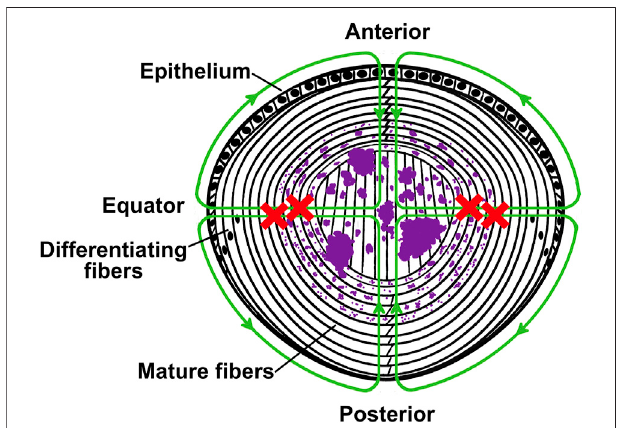
FIGURE 7 | Model illustrating the mechanism of formation of apatite deposits in the lens. The diagram depicts a cross sectional view of a mouse lens in which the lens circulation is impaired due to expression of a mutant connexin in the fi ber cells. In the healthy lens, ions and fl uid enter into the lensfromtheanteriorandposteriorpolesand movetothelenscenterthrough the extracellular spaces, and they exit across epithelial cell membranes at the equator. The green lines with arrowheads illustrate the circulation and the direction of fl ow of ions and fl uid in a normal healthy lens. The red crosses indicate that out fl ow of ions through fi ber cell-to- fi ber cell gap junctions is impaired due to the expression of the mutant connexin. This disruption leads to accumulation of calcium ions. As their concentration increases, the calcium ions react with the intracellular phosphate to form apatite precipitates (illustrated in purple). The crystals are initially small, but they become larger with